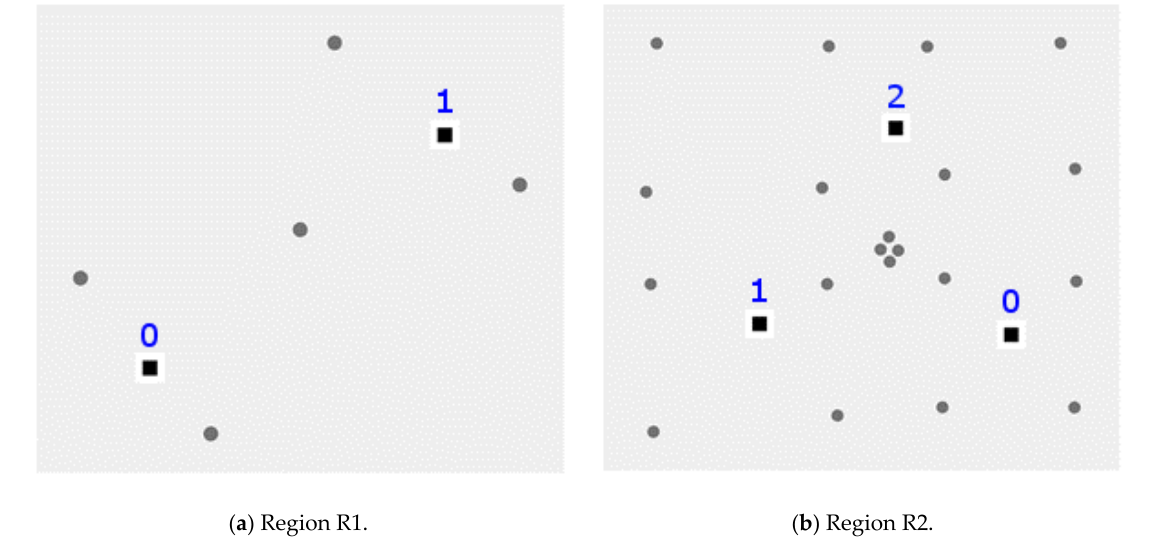
Figure 1. ( a ) Hypothetical two-shopping-centre system with five residential zones; ( b ) Hypothetical three-shopping-centre system with 20 population zones (retail zones are marked by squares and residential zones by circles).